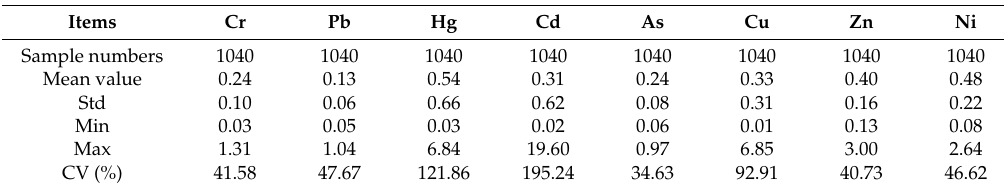
Table 2. Descriptive statistics of the single heavy metal pollution index (PI) of heavy metals in the study area.